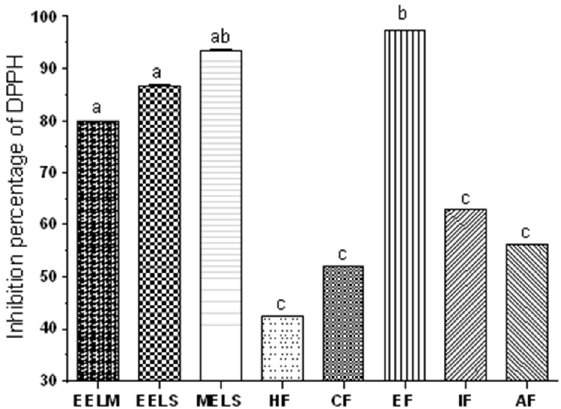
Figure 4 - Percentage of inhibition of DPPH radicals from leaf extracts of Stevia UEM-13 (1 mg/ml). Mean values with different superscript letters indicate significant differences (P > 0.05). The letters represent the following: EELM: Ethanolic Extract of Leaves (maceration); EELS: Ethanolic Extract of Leaves (Soxhlet); MELS: Methanolic Extract of Leaves (Soxhlet); HF: Hexane Fraction; CF: Chloroform Fraction; EF: Ethyl acetate Fraction; IF: Isobutanol Fraction, AF = Aqueous